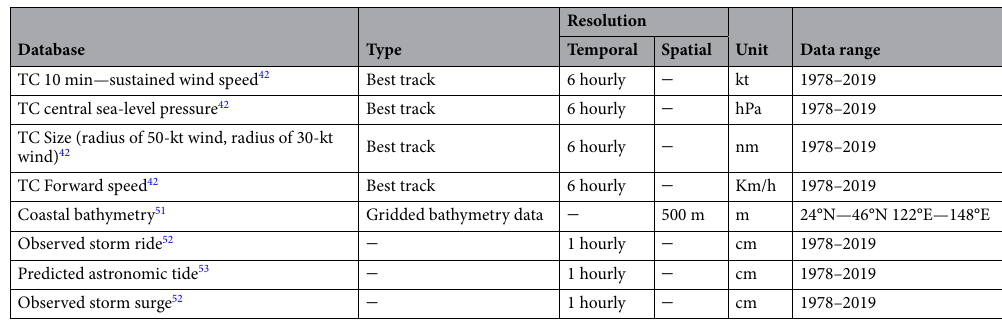
Table 2. TC databases and their scope and limitations based on coverage, resolution, and